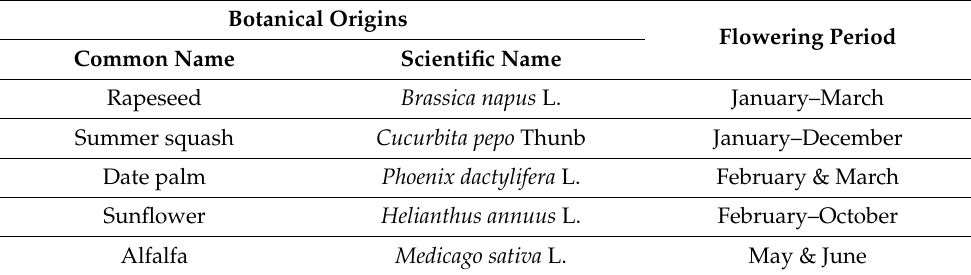
Table 1. Major pollen floral sources in the Al-Ahsa Oasis in 2020/2021.